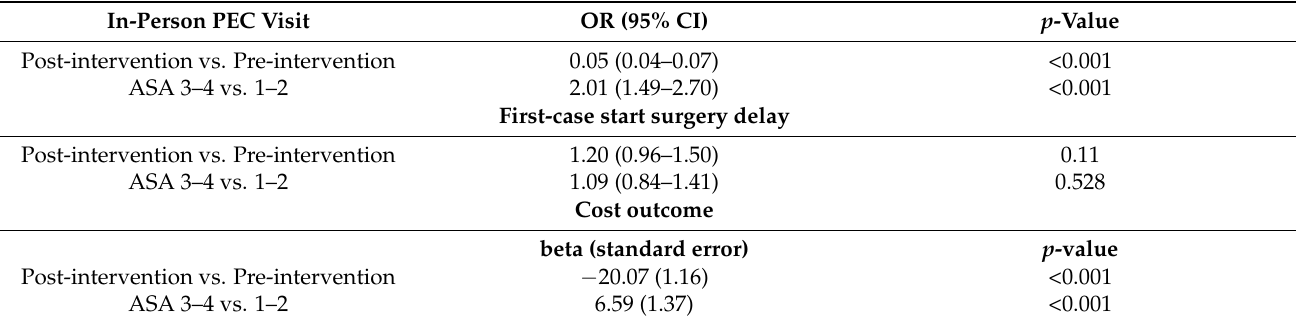
Table 3. Adjusted outcome